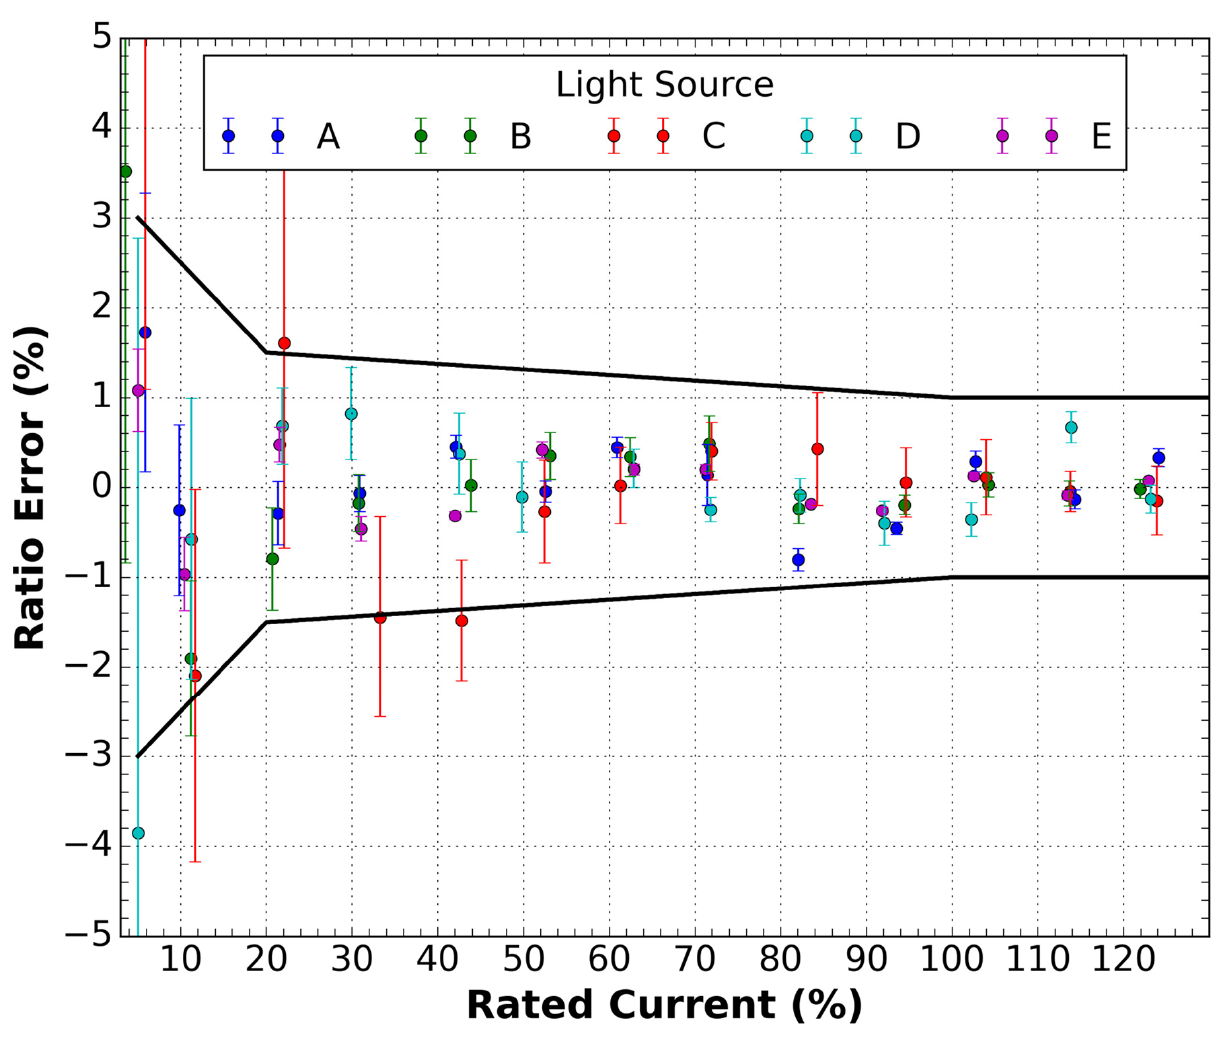
Figure 4. Ratio error curve as a function of the rated current for various evaluated light sources.